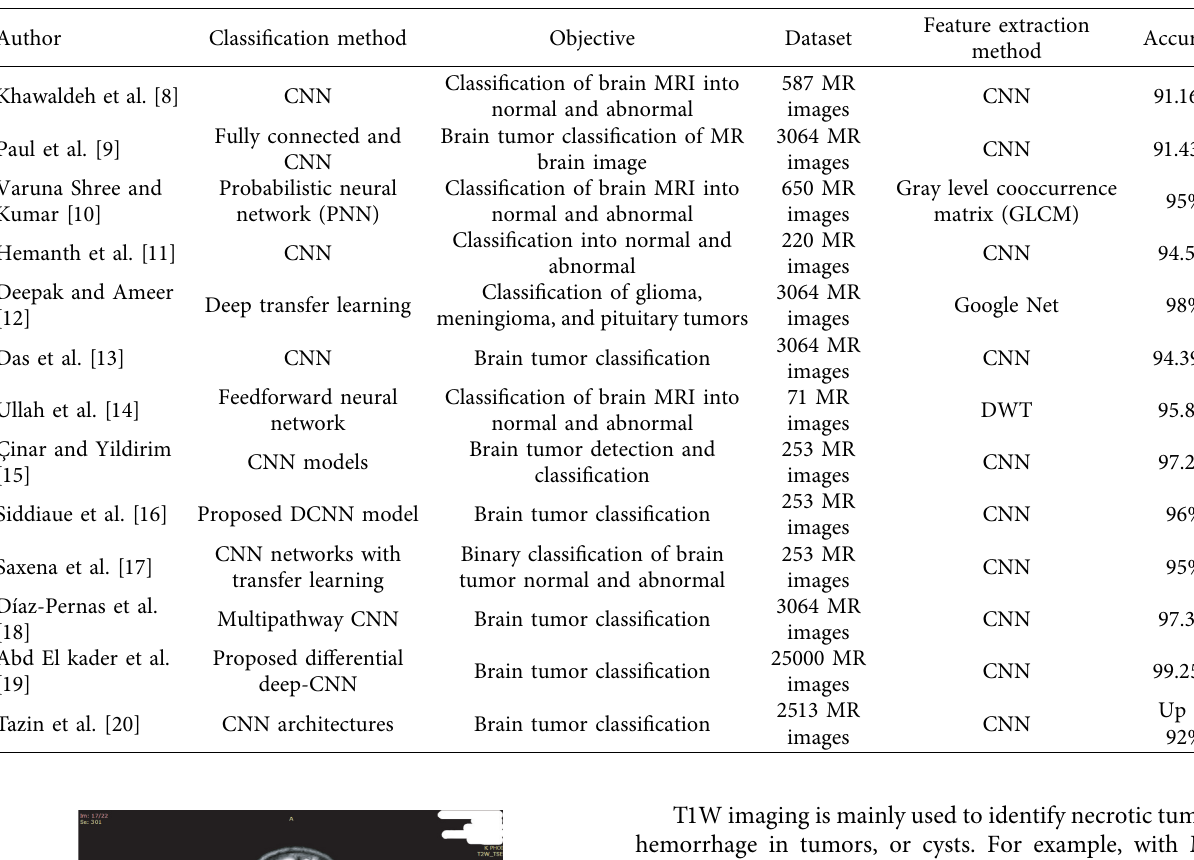
Table 1: Summary of studies on brain tumor